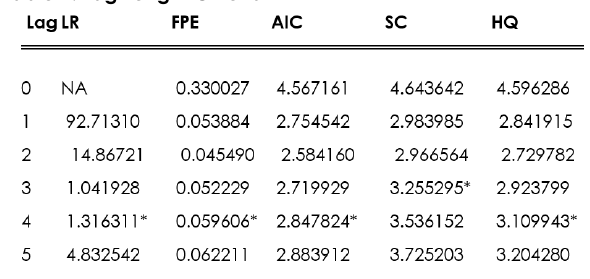
*, indicates lag order selected by the criterion.